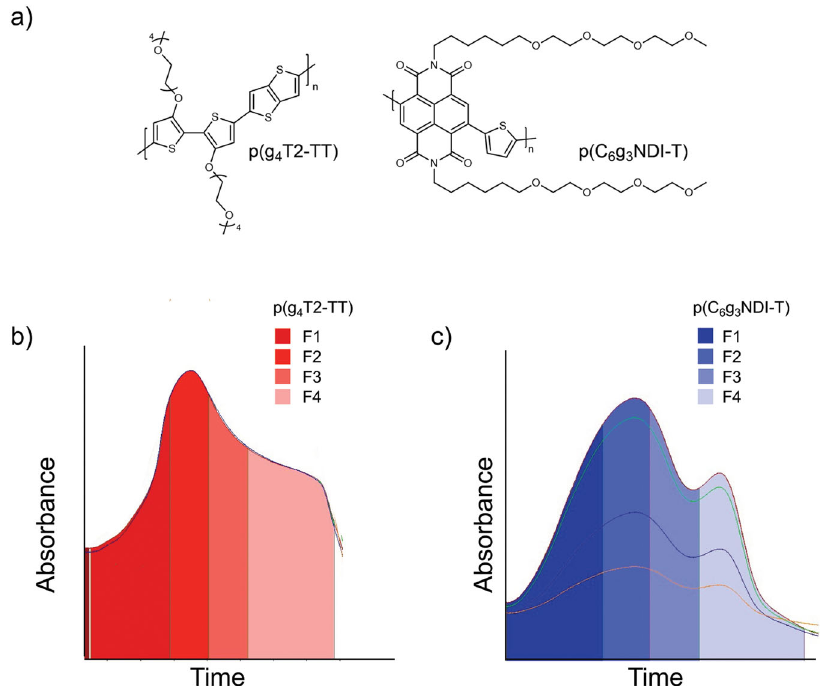
Fig. 1 | Chemical structures and fractionation traces of the two investigated polymer. a Chemical structures of p(g 4 T2-TT) and p(C 6 g 3 NDI-T). The preparative gel permeation chromatography trace for b p(g 4 T2-TT) and c p(C 6 g 3 NDI-T)